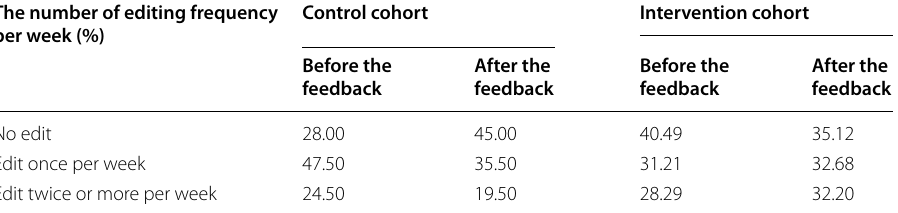
Table 1 The number of editing frequency per week (%) among cohorts The number of editing frequency per week (%)